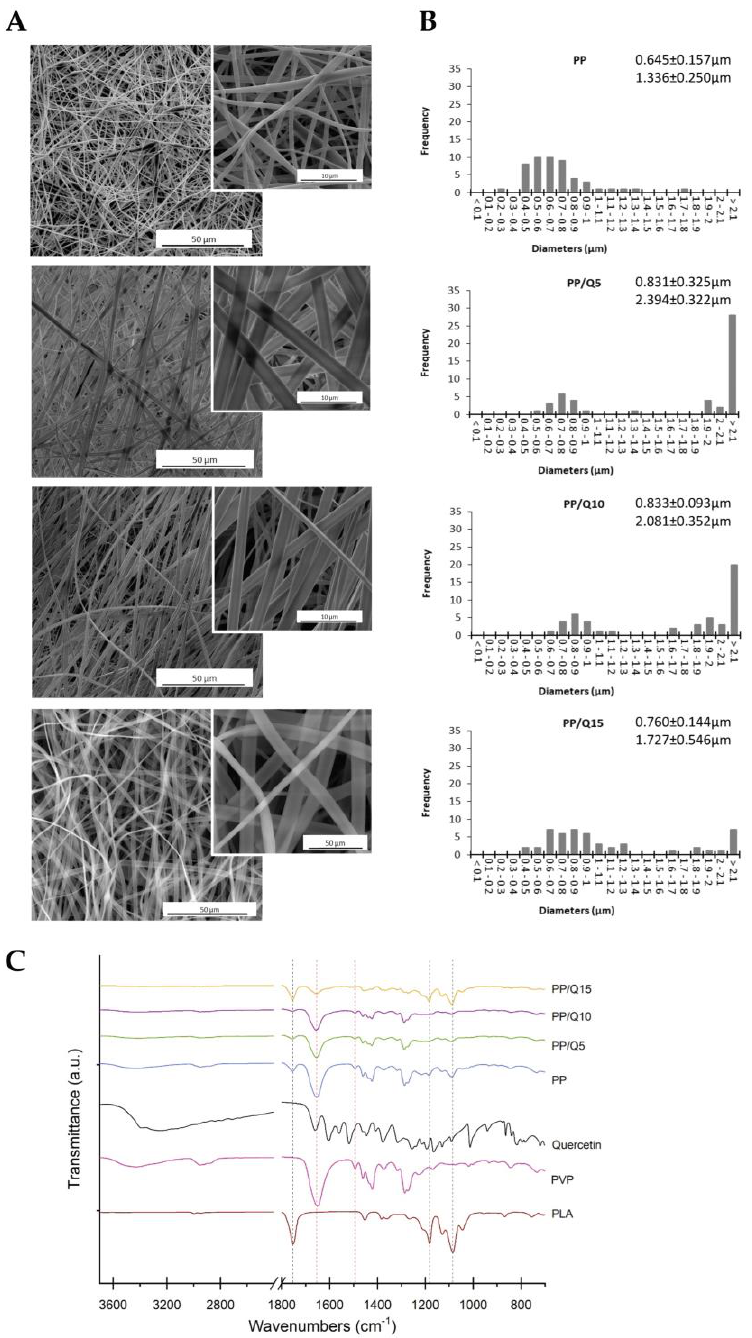
Figure 1. Characterization of the PLA-PVP/QUE membranes (PP/Qx): ( A ) SEM micrographs and ( B ) Fiber diameter distribution of PP, and PP at different QUE concentration (5, 10, and 15 coded as PP/Q 5 , PP/Q 10 , and PP/Q 15 , respectively). ( C ) FTIR-ATR spectra of quercetin, neat PLA, PVP, PP, PP/Q 5 , PP/Q 10 , and PP/Q 15 fibers.